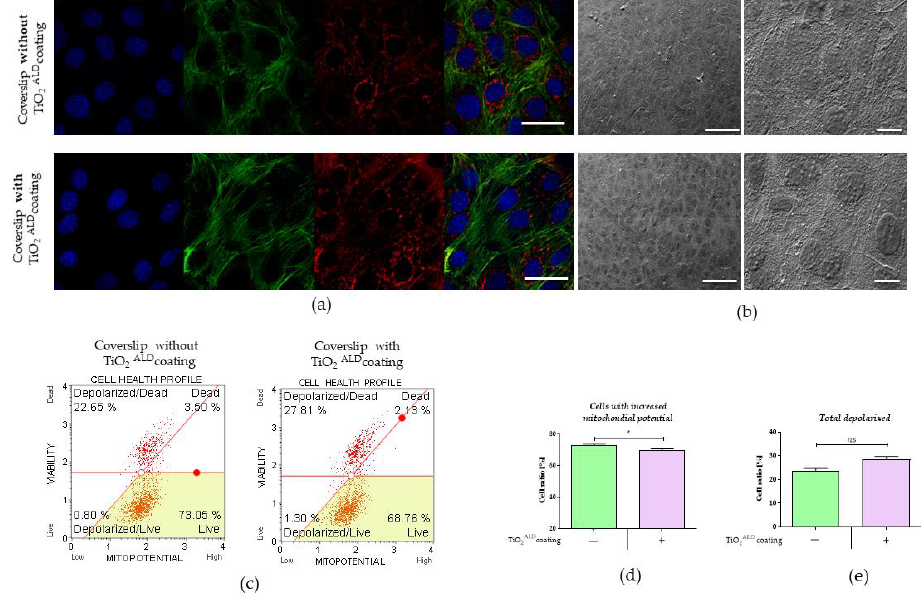
Figure 8. The results of the ultrastructural analysis of MC3T3 cells in the control culture (TiO 2 ALD coatings -) and a culture propagated on TiO 2 coatings obtained by ALD (TiO 2 ALD coatings +; experimental culture): ( a ) confocal imaging showing nuclei organisation (blue—stained with DAPI), an actin cytoskeleton (green—Atto 488 Phalloidin), and the distribution of the mitochondrial network (red—mitoRed). The pictures were captured under magnification equal to 630 × (scale bar = 40 µ m); ( b ) the ultrastructure of the MC3T3-E1 cells. The pictures were captured using SEM under 500 × magnification (scale bar = 100 µ m and magnification equal to 2500 × ); ( c ) Dot-plots presenting distribution of cells based on mitochondrial membrane potential. Cells were separated into four populations: live (Live—bottom-right corner), live with the depolarised mitochondrial membrane (Depolarized / Live—bottom-left corner), dead with the depolarised mitochondrial membrane (Depolarised / Dead—upper-left corner), and dead (Dead—upper-right corner). The results of the statistical analysis showing the percentage of cells with ( d ) high mitochondrial potential and ( e ) total depolarised cells. (significant di ff erences are marked with asterisks (* p < 0.05), non-significant results are marked as ns).